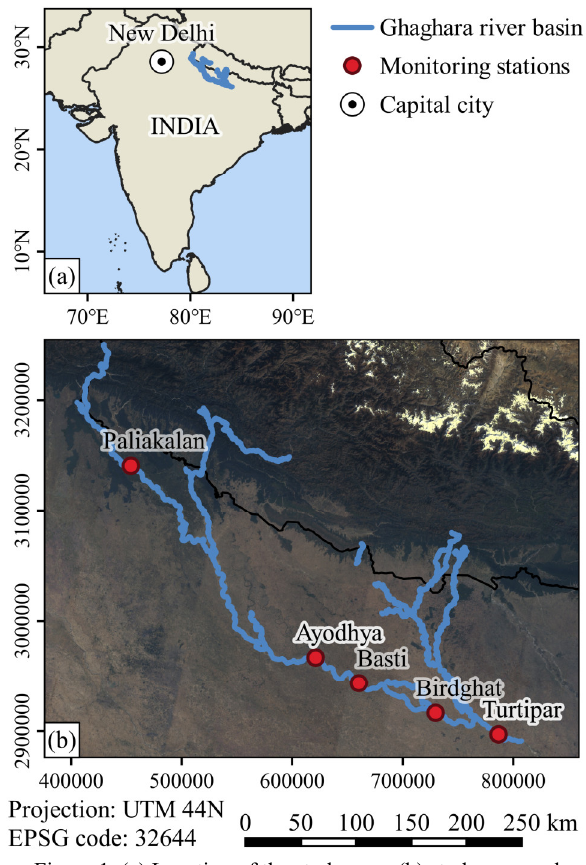
Figure 1. (a) Location of the study area, (b) study area and monitoring stations on Ghagraha River basin (Landsat 5 ‘true color’ composite (B3–B2–B1) for 2010) In order to allow a large temporal overlap of satellite data with ground truth data, this research is based on clear-sky Landsat 5 data (Figure 2). The atmospherically pre-corrected surface reflectance data were used from the Landsat 5 sensor